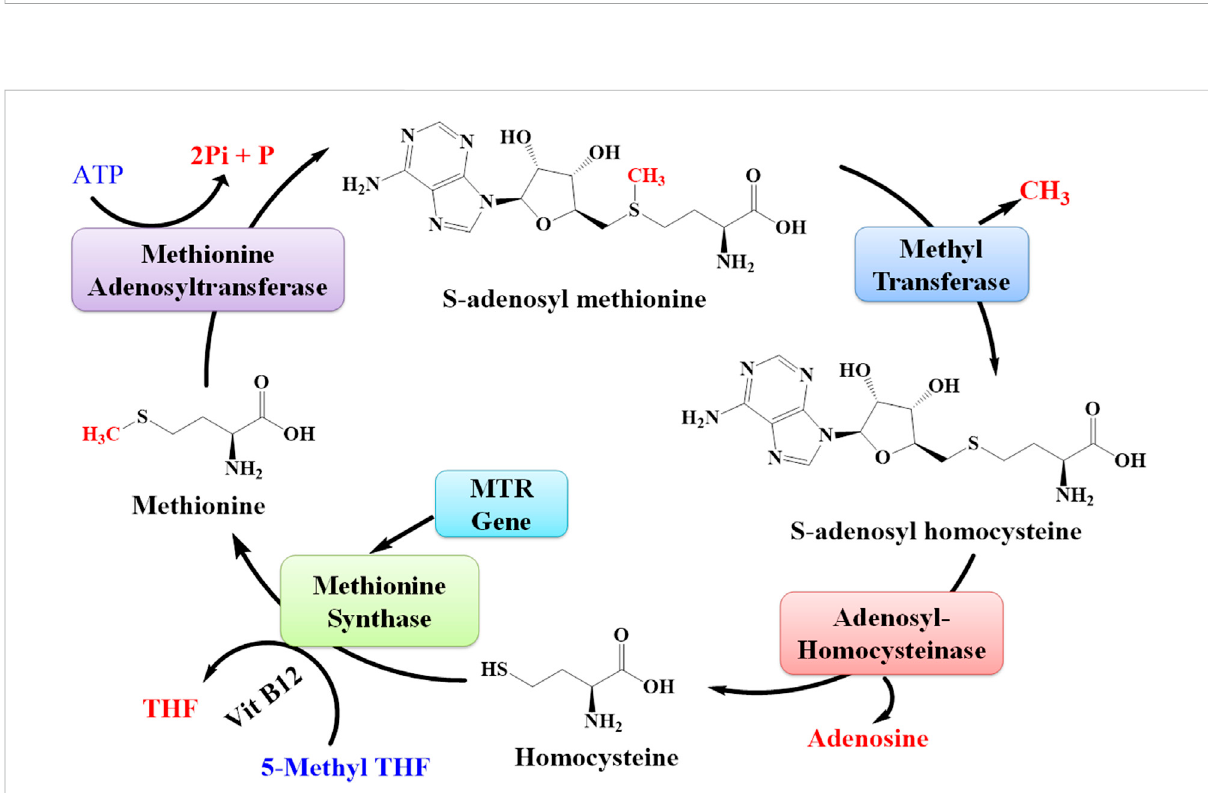
FIGURE 12 Pathway for the synthesis of methionine from S-adenosyl methionine. The MTR gene is responsible for synthesizing the enzyme methionine synthase that plays an important role in the synthesis of methionine amino acids.